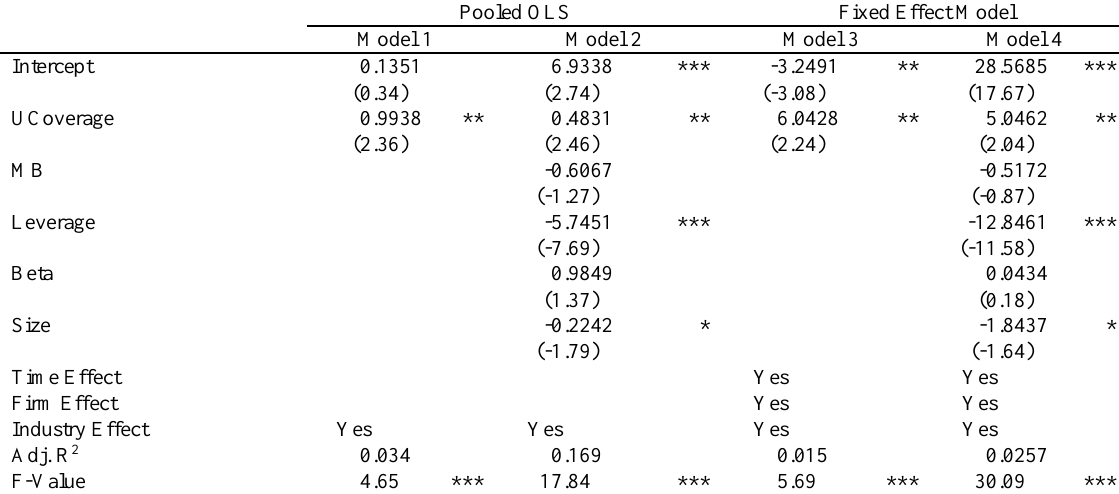
Table 6: Test results on hypothesis 1 for equity cost by using union coverage